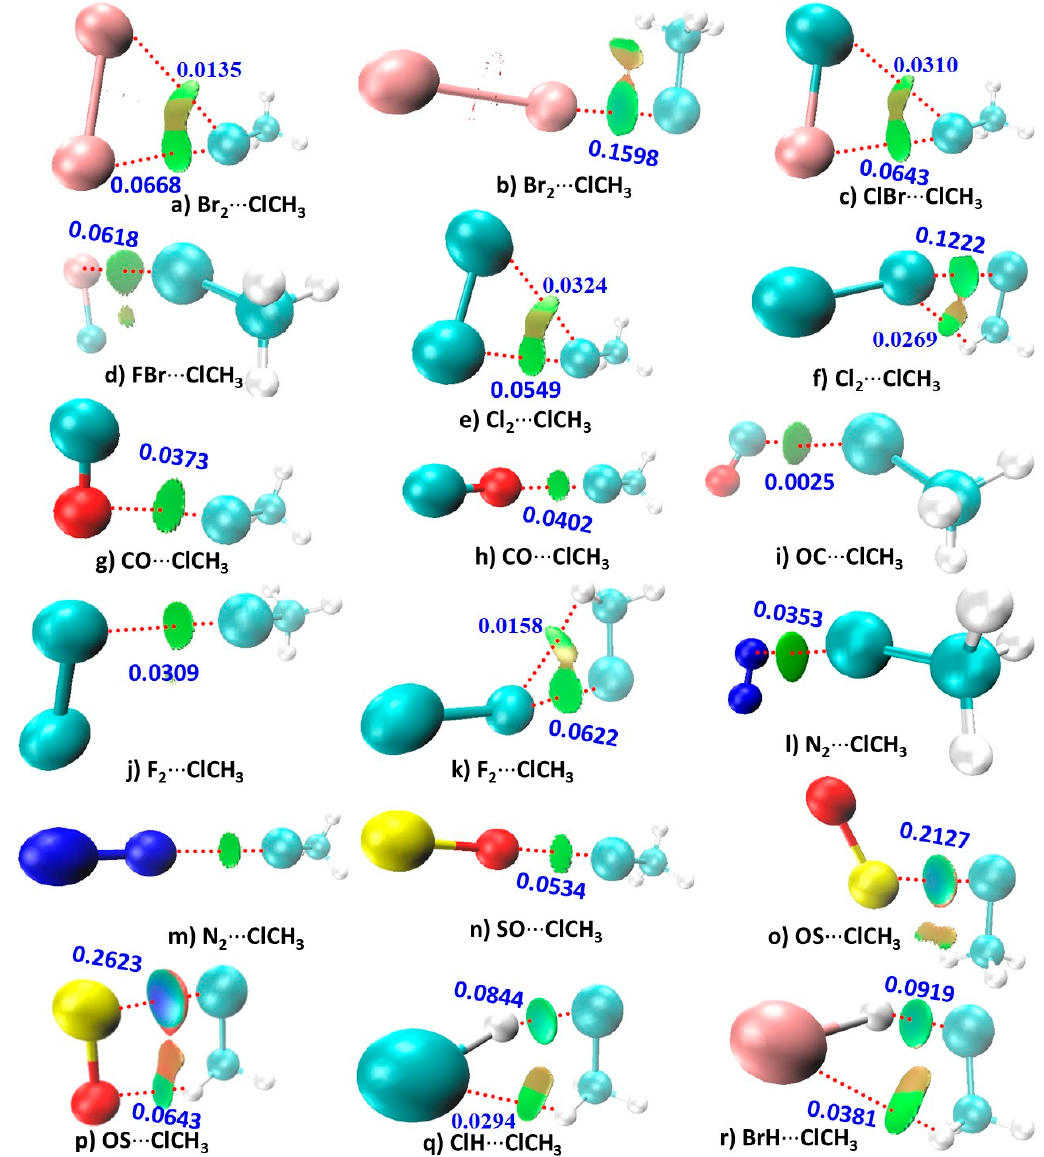
Figure 4. The MP2 / aug-cc-pVTZ computed reduced density gradient (RDG) isosurface topologies for the 18 binary complexes of CH 3 Cl studied. The delocalization indices (DIs) corresponding to selected atom – atom pairs are shown for each complex. The blue, green, and brownish isosurfaces represent strong, medium-strength, and weakly bound attractive interactions, respectively, whereas that in red represents repulsive interactions.